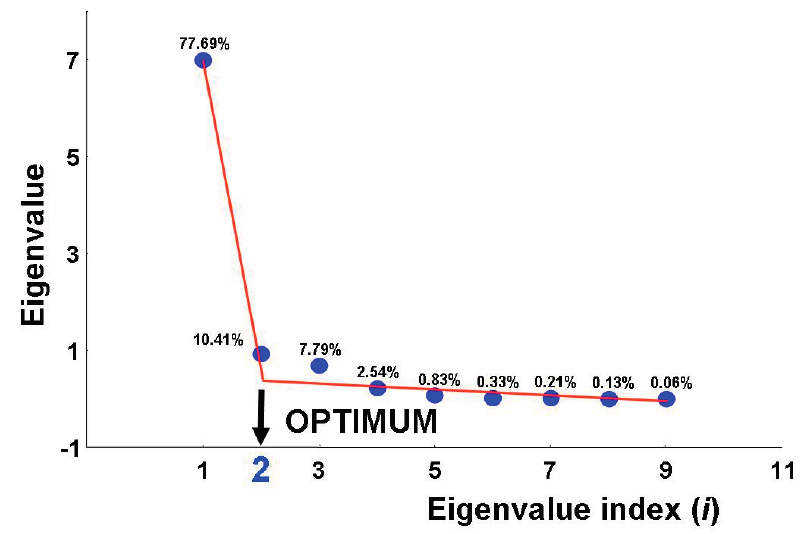
Figure 9. Scree-plot obtained from reflectance data concerning “vegetation”, “lake”, and “urban” classes (El-Fayoum Egyptian region). The number of structural eigenvalues is most probably equal to two.